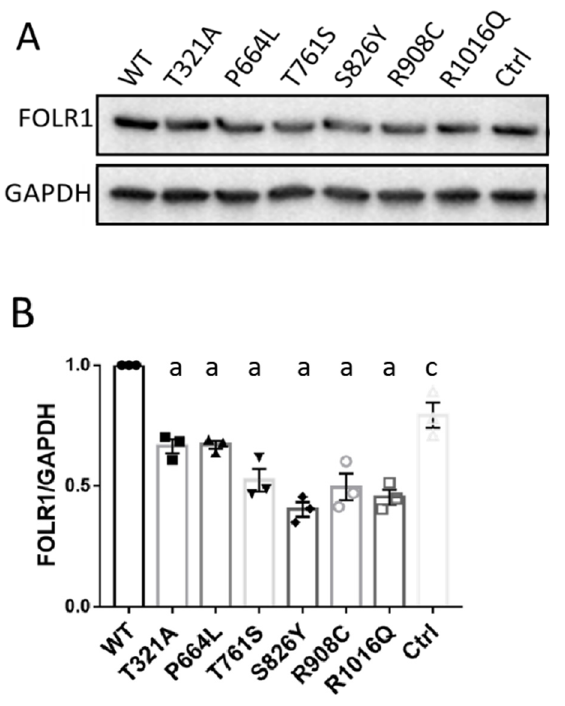
Figure 3. Overexpression of KDM6B mutants affected FOLR1 protein level and folate uptake ability of HeLa cells. ( A ) HeLa cells were transfected with mutated and wild-type constructs of Flag-tagged KDM6B and pcDNA3.1 backbone vector for 48 h, and Western blotting was performed to quantify FOLR1 protein level in each group. GAPDH was used as loading control. ( B ) Western blotting was repeated three times and a Student t -test was performed to compare the protein levels between wild-type and mutant. Significance compared to WT: “a” represents p < 0.001; “c” represents p < 0.05.